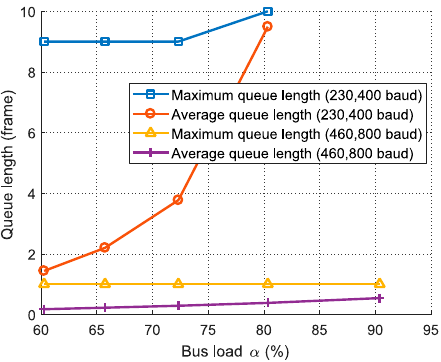
Figure 14. Difference between the average and maximum RX queue lengths. Figure 14. Di ff erence between the average and maximum RX queue